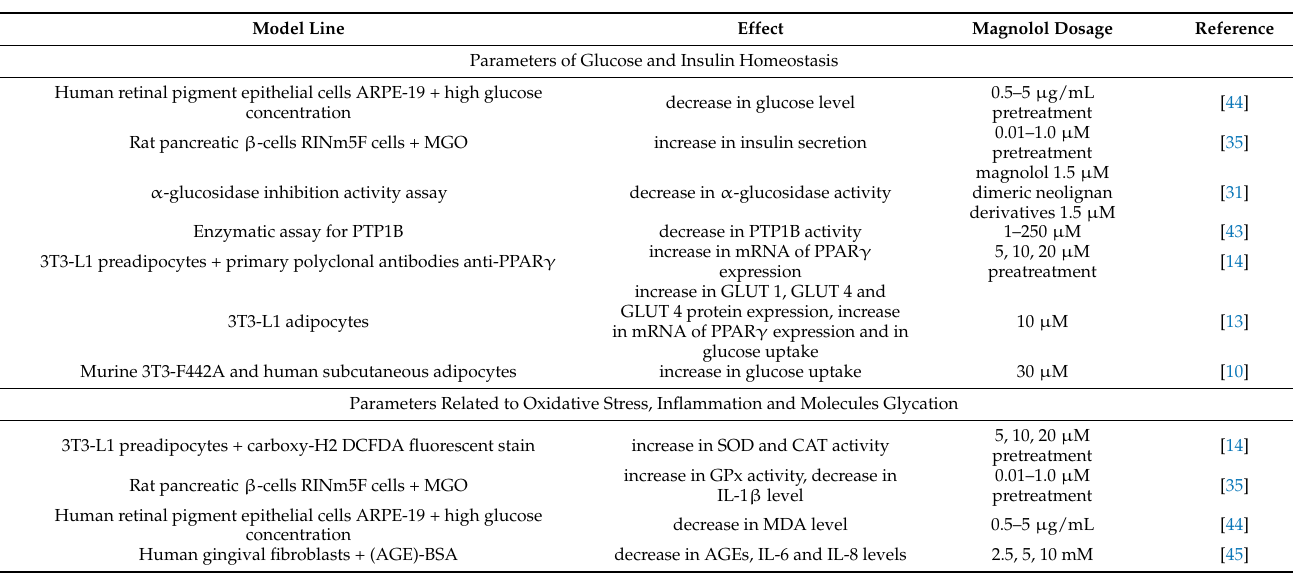
Table 1. Antidiabetic activity and the effect of magnolol on the basic parameters of oxidative stress in in vitro studies.